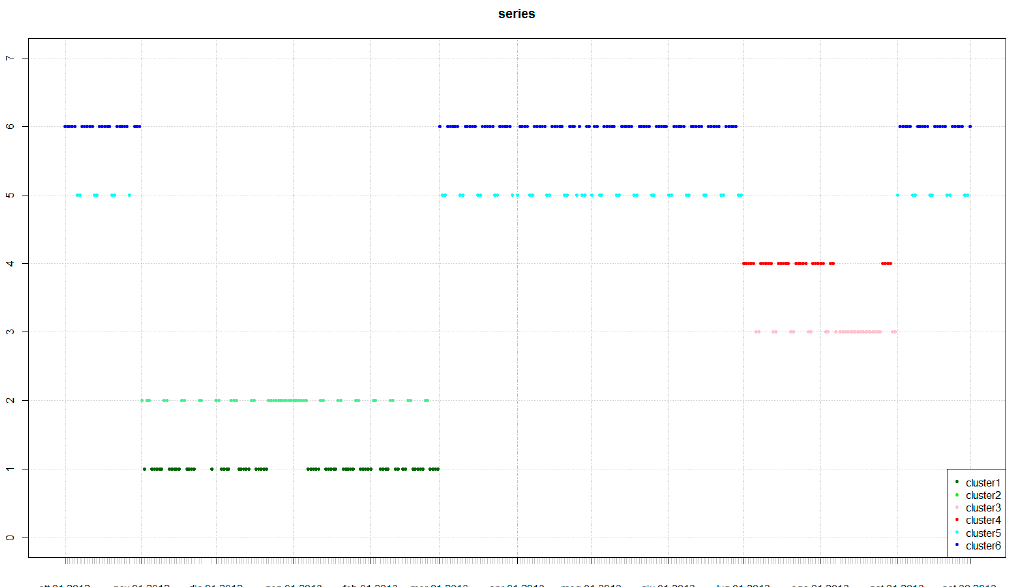
Figure 5. A graph showing the cluster assignment over the observation period. Although the final cluster label is used, it is easy to also identify the three clusters obtained at the first level; cluster1 & cluster2, cluster3 & cluster4, and cluster5 &